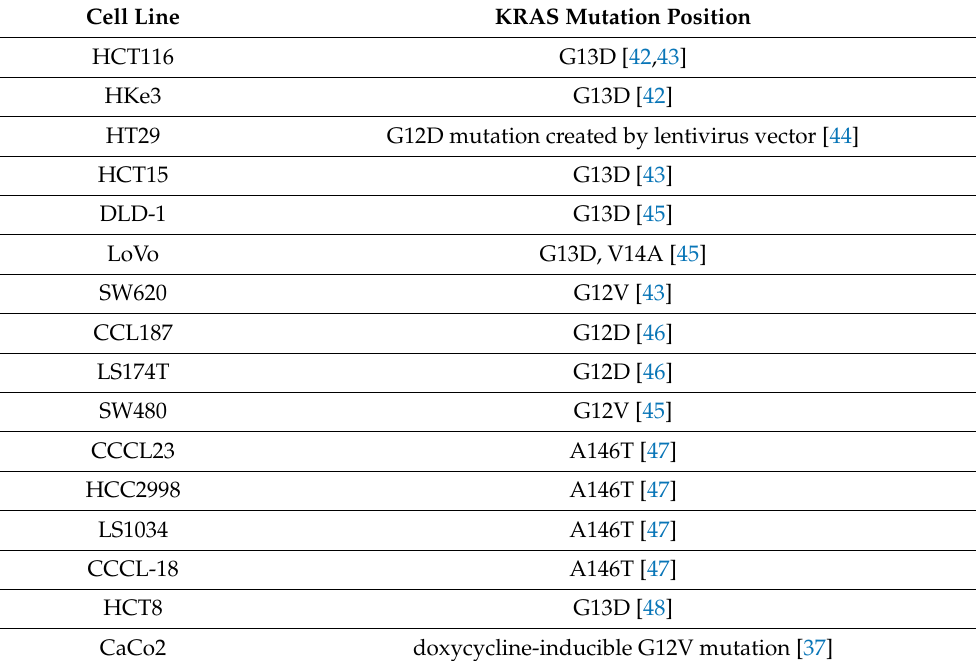
Table 2. Summary of the in vitro experimental model systems currently used in CRC research showing that CRC cell lines harbouring specific KRAS mutations are useful tools for drug screening and for modelling the development of therapeutic